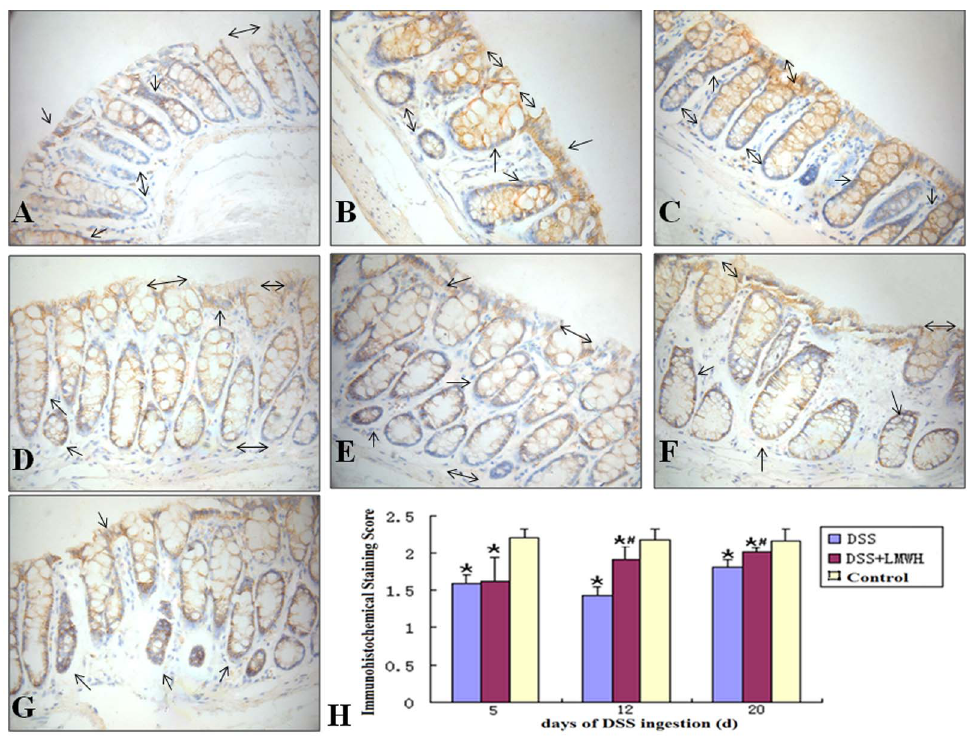
Figure 4. Protein expression of syndecan-1 in the intestinal mucosa. A–G: The tissue sections were subjected to immunohistochemical analysis with the syndecan-1 antibody. Syndecan-1 was expressed on the membranes of epithelial cells and gland cell membranes (single arrow head) in control mice (G). A marked staining reduction was detected in mice of the DSS group (A, day 5; B, day 12; C, day 20; double arrow heads). Partial epithelial membranes and gland cell membranes are moderately stained in colon mucosa of mice in the DSS plus LMWH group (D, day 5; E, day 12; F, day 20; double arrow heads). Original magnification: 6 400. H: Quantization of sydecan-1 immunostaining (n=18/group). * P , 0.05 vs. the control; # P , 0.05 vs. the DSS group. doi:10.1371/journal.pone.0066397.g004 antibody (1 mg/ml in TTM) for 2 h at room temperature. After washing twice, the dots were visualized by incubation of the membranes in ECL solution and then exposed. Finally, the IOD value was quantified.